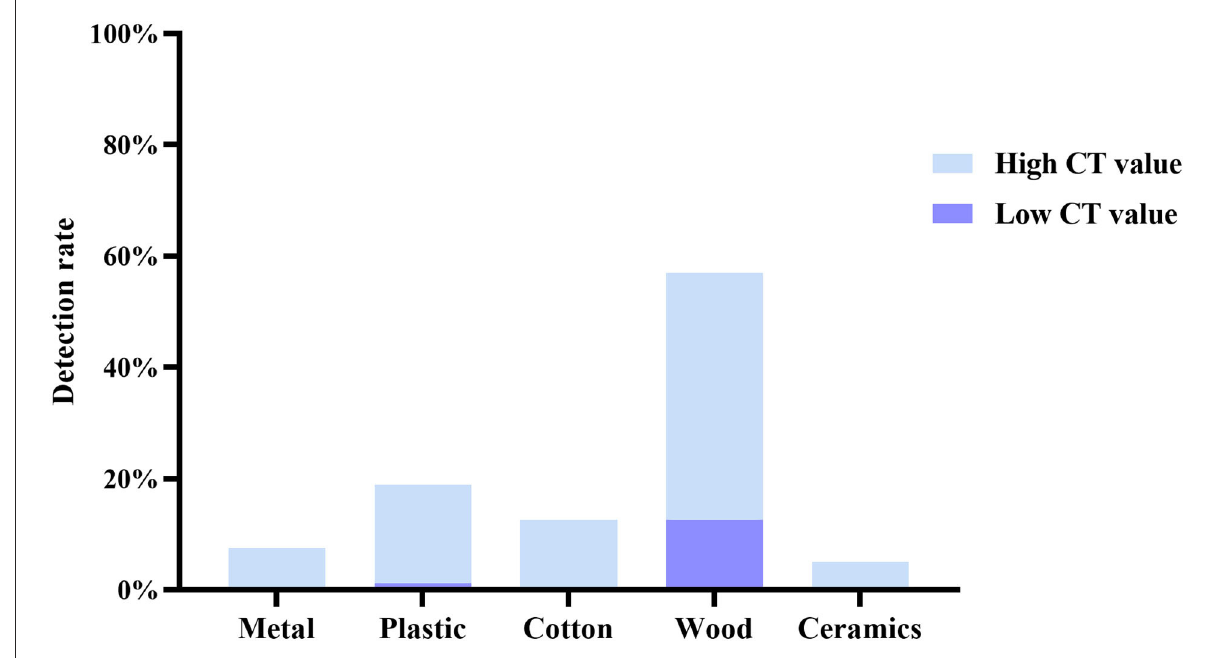
FIGURE2 Detection rate of SARS-CoV-2 RNA in environmental specimens of various